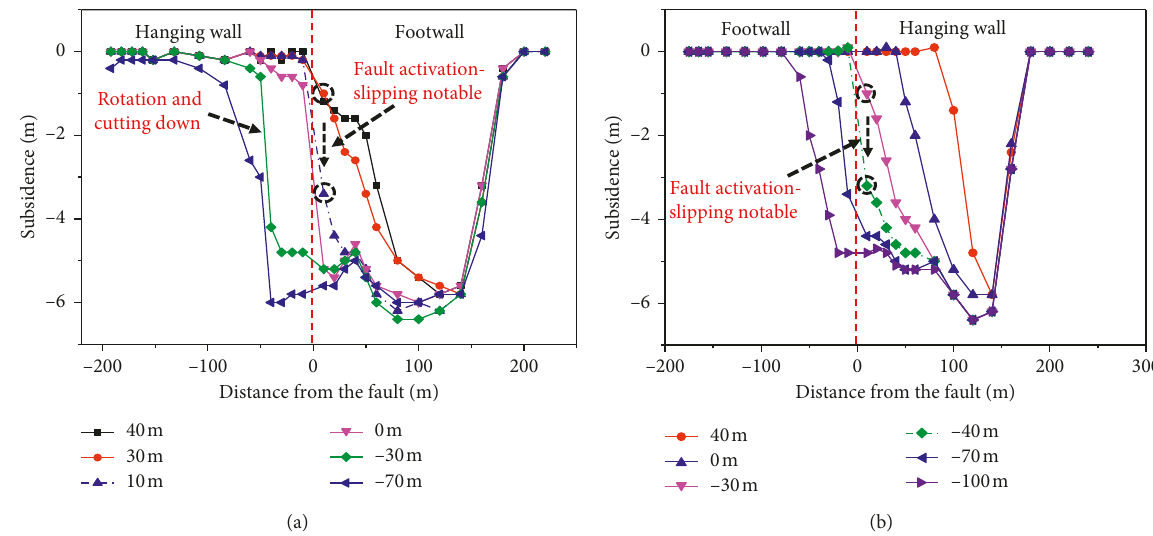
Figure 5: Displacement of overlying strata with different mining directions. (a) Footwall mining. (b) Hanging wall